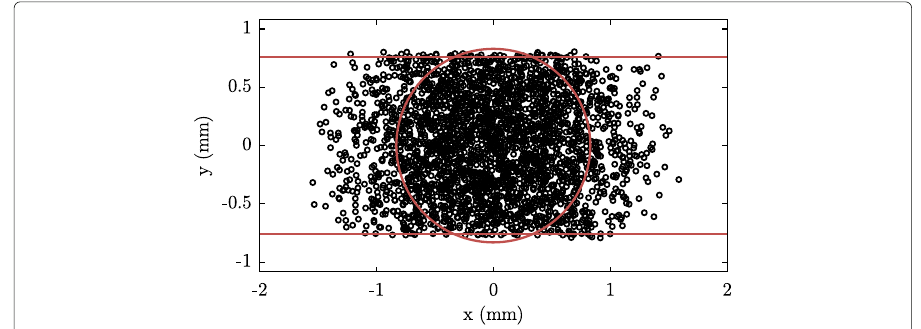
Fig. 10 Transverse position distribution of simulated argon atoms at the longitudinal position where the atoms first collide with the stored ammonia molecules. The horizontal lines reflect the cut-off of the electrodes that make up the hexapole element through which the argon beam first enters the synchrotron. The circle approximates the circular cut-off due to the second skimmer. The resulting flattened circle shows the transverse shape of the argon beam that is used in trajectory simulations of ammonia